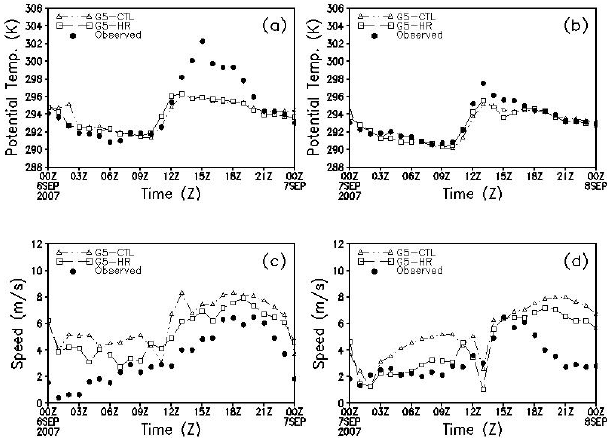
Figure 9. Time cross-section data of (a, b) θ (K), and (c, d) wind speed (ms − 1 ) observed (closed circle) and simulated by G5 of the CTL (open triangle) and HR (open square) runs from 00:00UTC 6 September to 00:00UTC 8 September 2007 at SBSC surface weather-observation station.